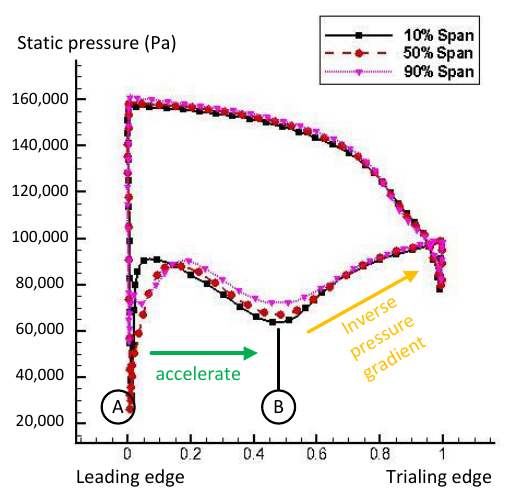
Figure 8. Blade loading of tip turbine at different spans (0% for hub and 100% for shroud).